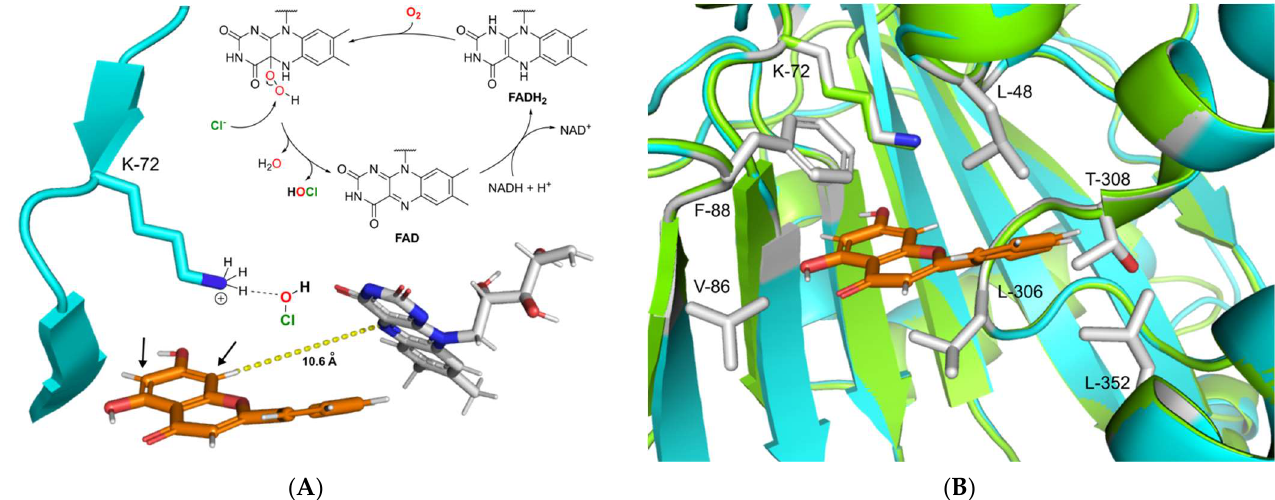
Figure 5. ( A ) Proposed catalytic mechanism of DklH. The halogenation agent hypochlorous acid is formed in an FAD- dependent manner and then coordinates through the active residue lysine-72 near the substrate binding pocket. Halogen- ation takes place at position 6 or 8 of substrate 2 , ortho to the 7-hydroxyl moiety. ( B ) Structural superimposition of the homology model of DklH (cyan) and template 3E1T (green). The ligand 2 is represented as orange sticks. Crucial residues responsible for substrate binding and cavity formation are shown as sticks coloured by element.